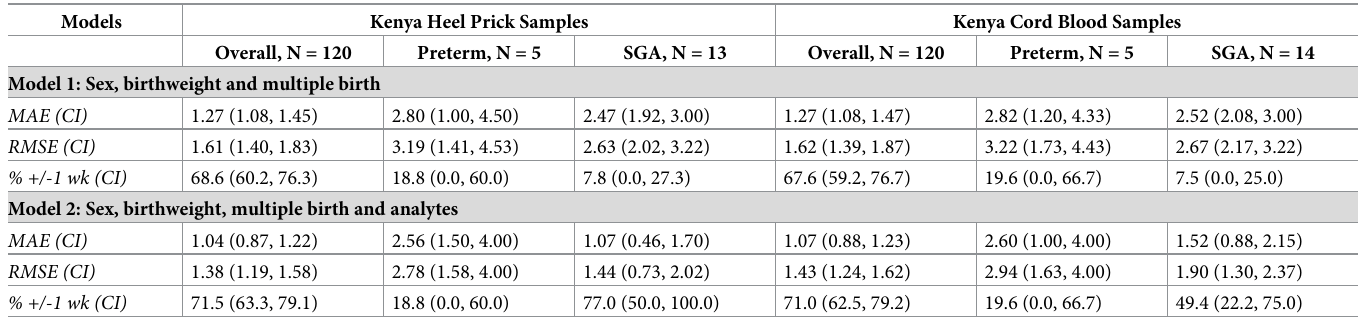
MAE: Mean absolute error; RMSE: Root mean square error; SGA: small for gestational age Data are presented as the mean and 2.5th and 97.5th bootstrap percentiles for MAE, RMSE and the percentage of model estimates within 1 and 2 weeks of ultrasound GA for 1000 bootstrap samples generated from each